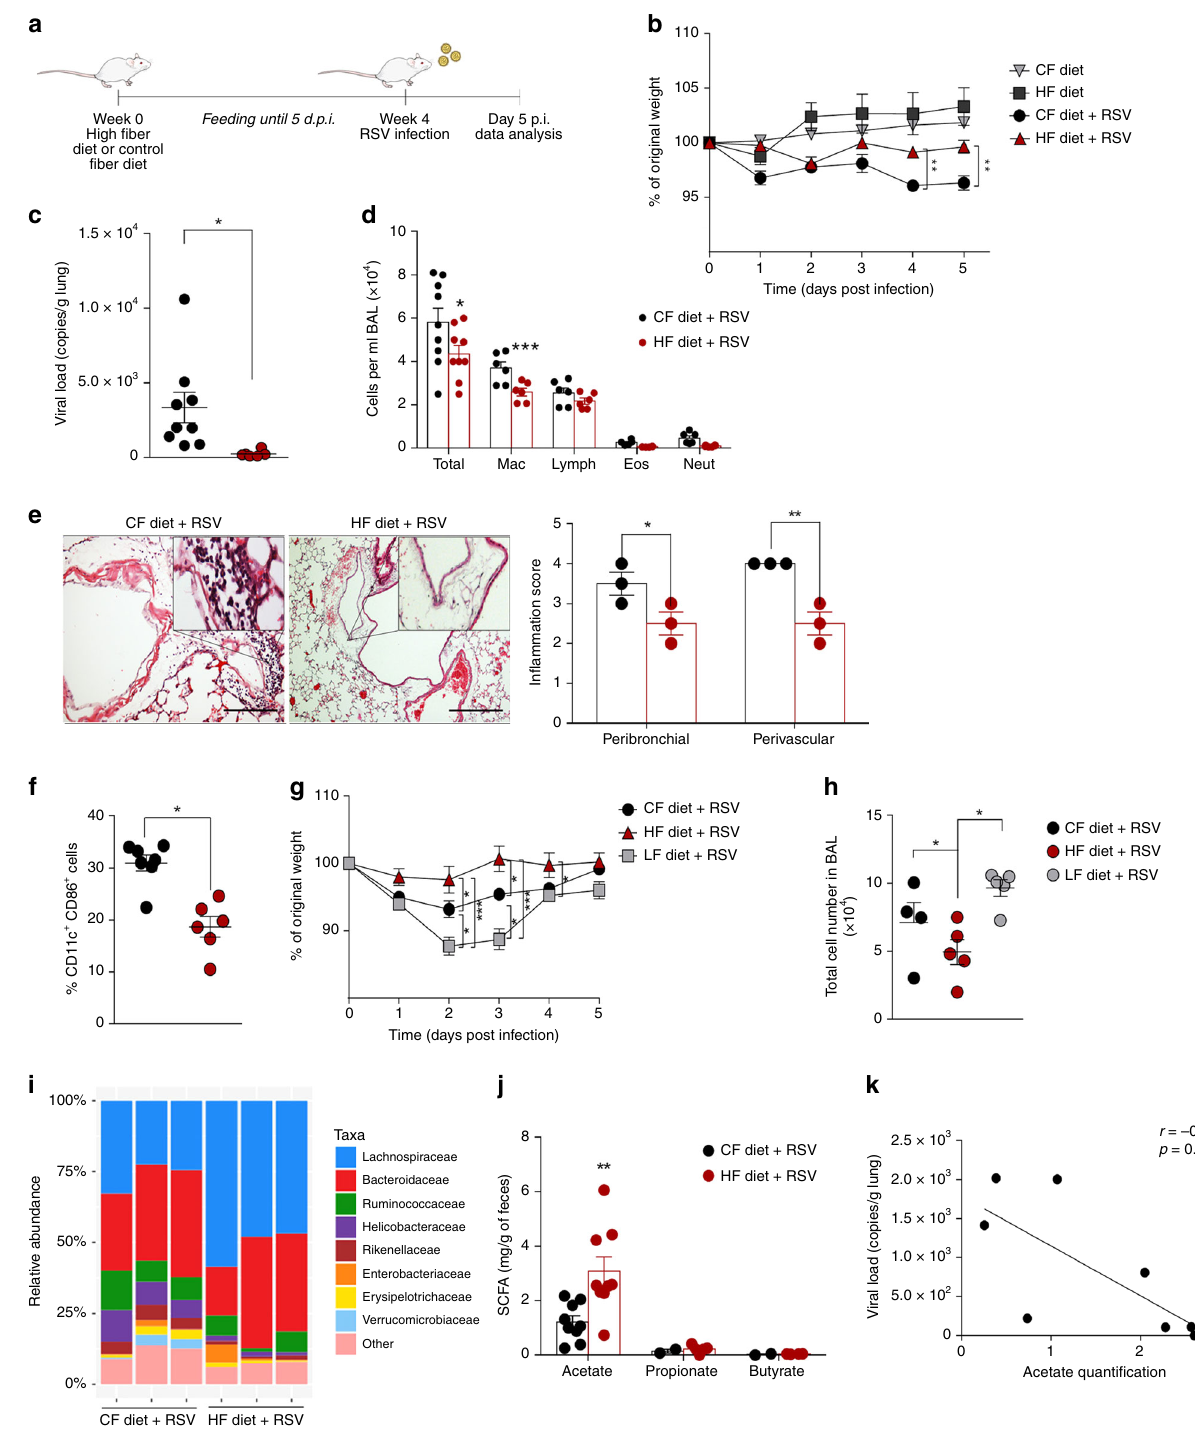
Fig. 1 High- fi ber diet protects mice against RSV-induced disease. a Female BALB/c mice were fed with control fi ber (CF) or high- fi ber (HF) diets for four weeks before and during RSV infection. Analyses were performed on day fi ve post infection. b Percentage of weight loss post infection relative to initial body weight (day 0) ( n = 9). c RSV viral load detected in lung tissue by real-time PCR (viral copies/g of lung tissue) ( n = 9). d Total cell number and differential cell counts in bronchoalveolar lavage fl uid (BALF) ( n = 9). e Representative images of lung tissue section stained with hematoxylin and eosin (H&E) and its respective in fl ammation scores ( n = 3). Scale bars = 100 μ m. f Percentage of CD11c + CD86 + cells in axillary lymph nodes ( n = 6). g , h Female BALB/c mice were fed with control fi ber (CF), high- fi ber (HF) or low- fi ber (LF) diet for four weeks before and during RSV infection. Analyses were performed at day fi ve post infection. g Percentage of weight loss post infection relative to initial body weight (day 0). h Total cell number in BALF ( n = 5). i Analysis of the fecal microbiota composition from mice fed with CF and HF diets at the family level (relative abundance). j SCFA quanti fi cation in colonic luminal content (mg/g feces) ( n = 8). k Spearman linear correlation between viral load and acetate quanti fi cation of animals fed with control and high- fi ber diet. Data in a – e and j are from two independent experiments. All data are expressed as mean ± SEM and were compared using Kruskal – Wallis. In the other cases, Mann – Whitney was used. * p < 0.05, ** p < 0.01, *** p < 0.001. Data in b , c , d , g , h , j are provided as a Source Data fi